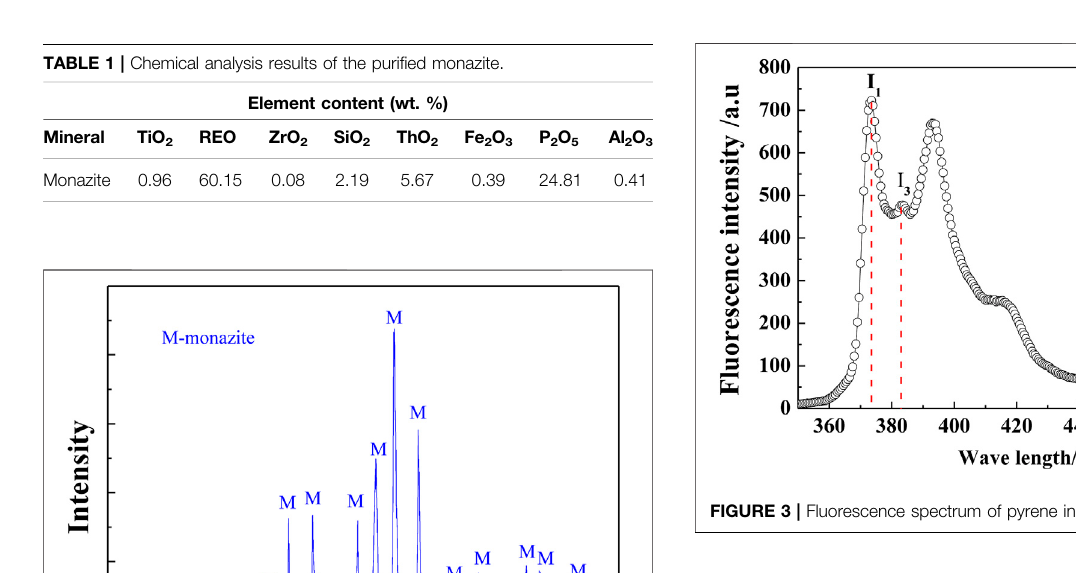
FIGURE 1 | Molecule structure of octyl hydroxamate (white, H; gray, C; red, O; blue, N).